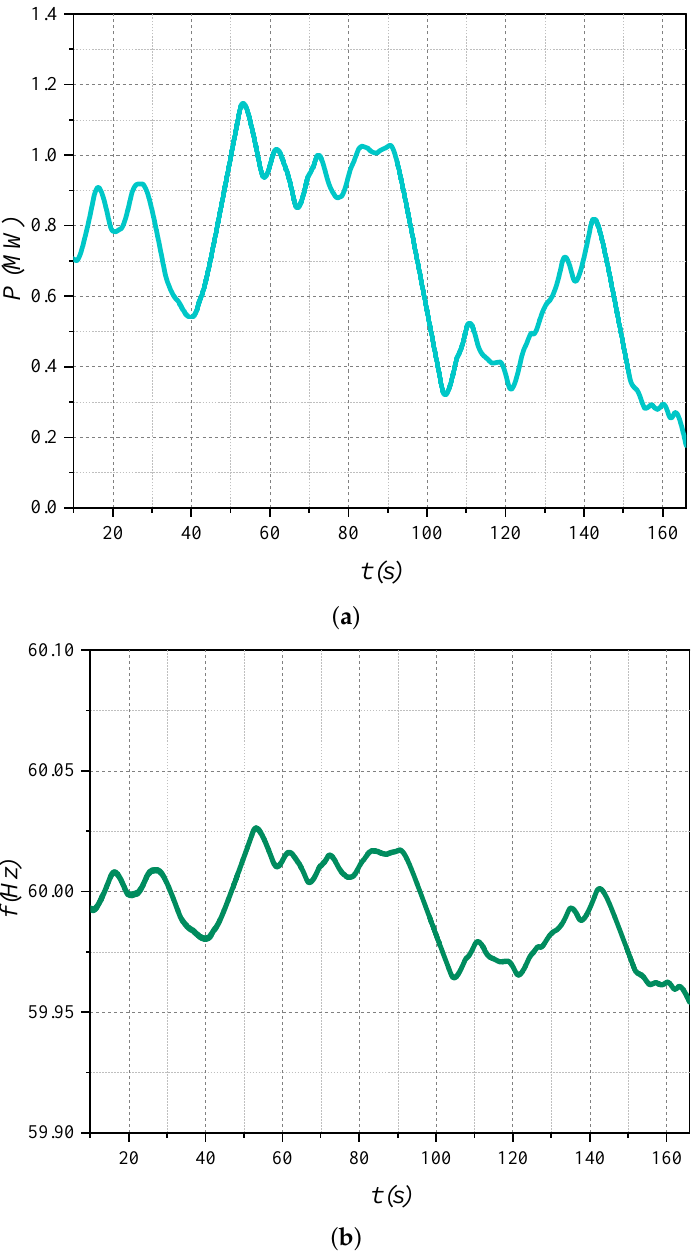
Figure 14. Impact of WG intermittent output power on microgrid frequency for the base-case scenario. ( a ) WG 1 output powe r. ( b ) Microgrid frequenc